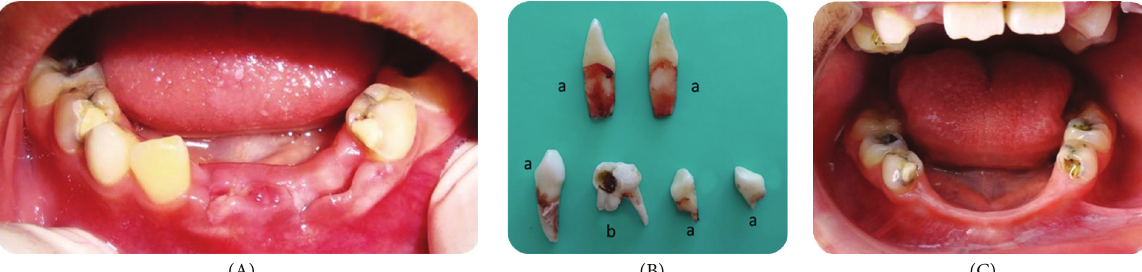
Figure 1: (A) Oral status of the patient on the first visit in the hospital. (B) a: teeth extracted by the patient, b: tooth extracted by the pediatric dentist. (C) Clinical examination (after 5 months).